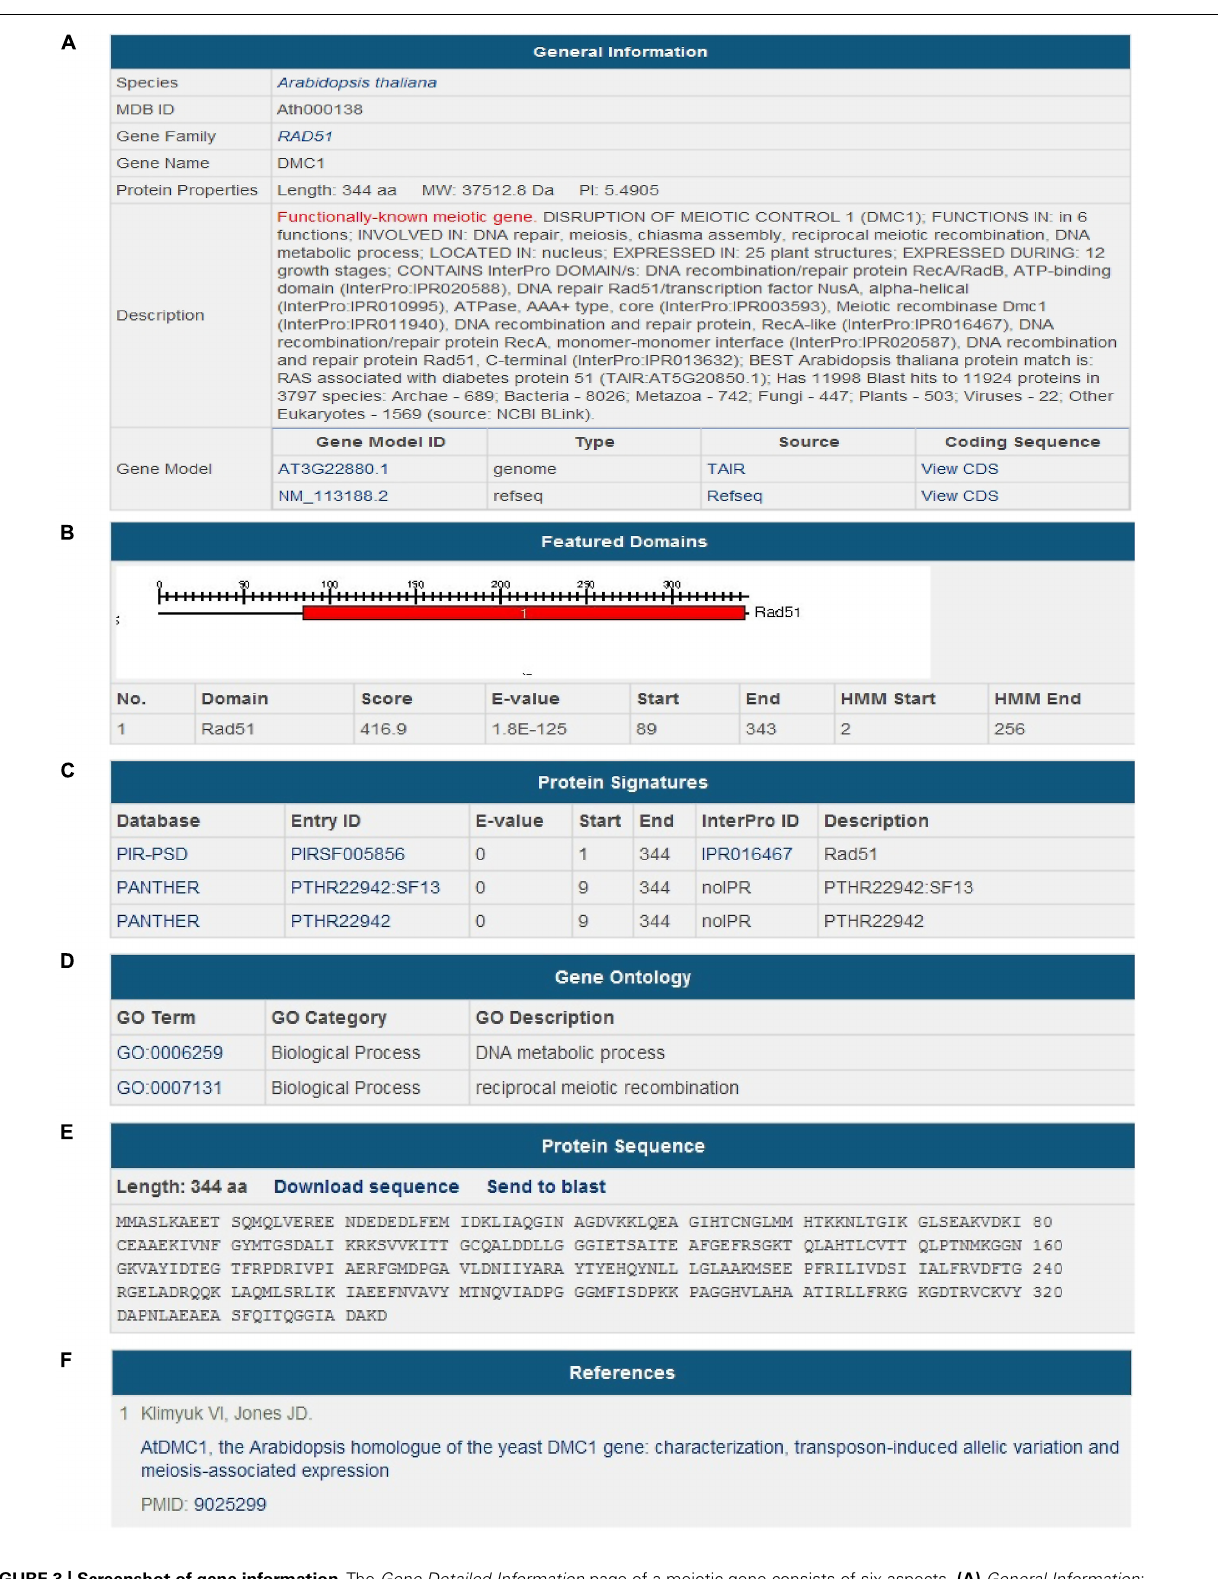
FIGURE 3 | Screenshot of gene information. The Gene Detailed Information page of a meiotic gene consists of six aspects. (A) General Information ; (B) Featured Domains ; (C) Protein Signatures ; (D) Gene Ontology ; (E) Protein Sequence ; (F) References .